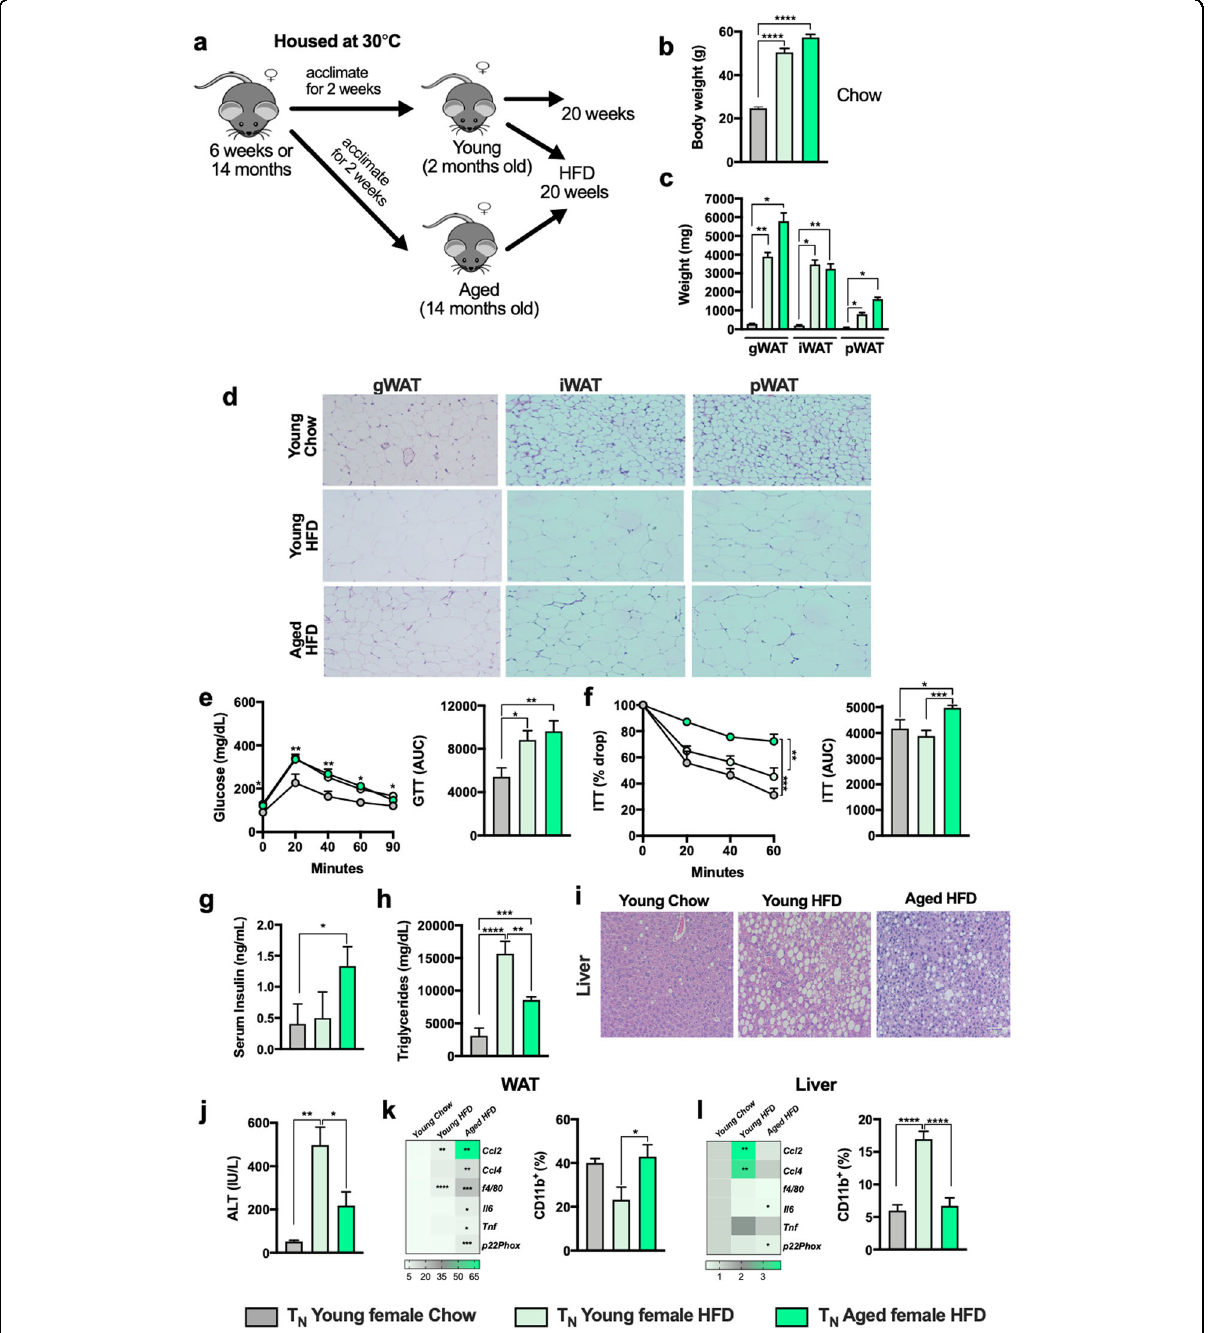
Fig. 4 Thermoneutral housing uncovers the impact of aging on metabolic disease severity independent of weight difference in female mice. 2-month-old (Young) and 14-month-old (Aged) female C57BL/6 mice, ( n = 4 – 9/condition) were housed at either 22 °C (T S ) or 30 °C (T N ) and fed Chow or HFD for up to 20 weeks. a Schematic representation of DIO model used. b Body weight at time of harvest. c White adipose tissue (WAT) weight: gonadal WAT (gWAT), inguinal WAT (iWAT) and perirenal WAT (pWAT). d gWAT, iWAT and pWAT hematoxylin eosin (H&E) staining. e Left, glucose tolerance test (GTT) and Right, GTT area under the curve (AUC). f Left, insulin tolerance test (ITT) and Right, ITT area under the curve (AUC). g Serum insulin levels. h Right-Heatmap of WAT mRNA levels of Ccl2, Ccl4 , f4/80 , Il6, Tnf and p22phox fold change relative to T N chow diet fed young female; Left-Flow cytometry quanti fi cation of WAT in fi ltrating CD11b + cells (CD45 + ). i Liver triglycerides. j Liver H&E staining. k Serum Alanine transaminase (ALT) levels. l Right-Heatmap of hepatic mRNA levels of Ccl2, Ccl4 , f4/80 , Il6, Tnf and p22phox fold change relative to T N chow diet fed young female; Left-Flow cytometry quanti fi cation of hepatic in fi ltrating CD11b + cells (CD45 + ). A representative of 2 individual experiments. Data represent means + SE. b , c , e – i , k – m ). One-way ANOVA * P < 0.05, ** P < 0.005, *** P 0.0005 and **** P <